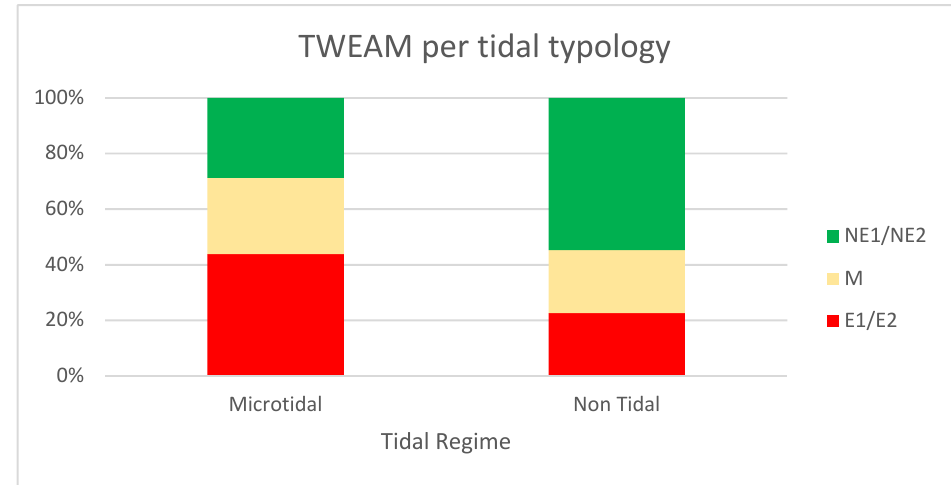
(microtidal and non-tidal). A total of 44.4% of the microtidal stations, which represent most of the Northern Adriatic sites, resulted in eutrophic status, 26.3 in mesotrophic status, and 29.2% in non-eutrophic status. Conversely, most of the non-tidal stations are in a non-eutrophic status (53.7%) and only 22.2% resulted in eutrophic status (Figure 7). The difference in the distribution of TWEAM classes among the two tidal typologies is significant ( χ 2 = 9.1, p < 0.05).